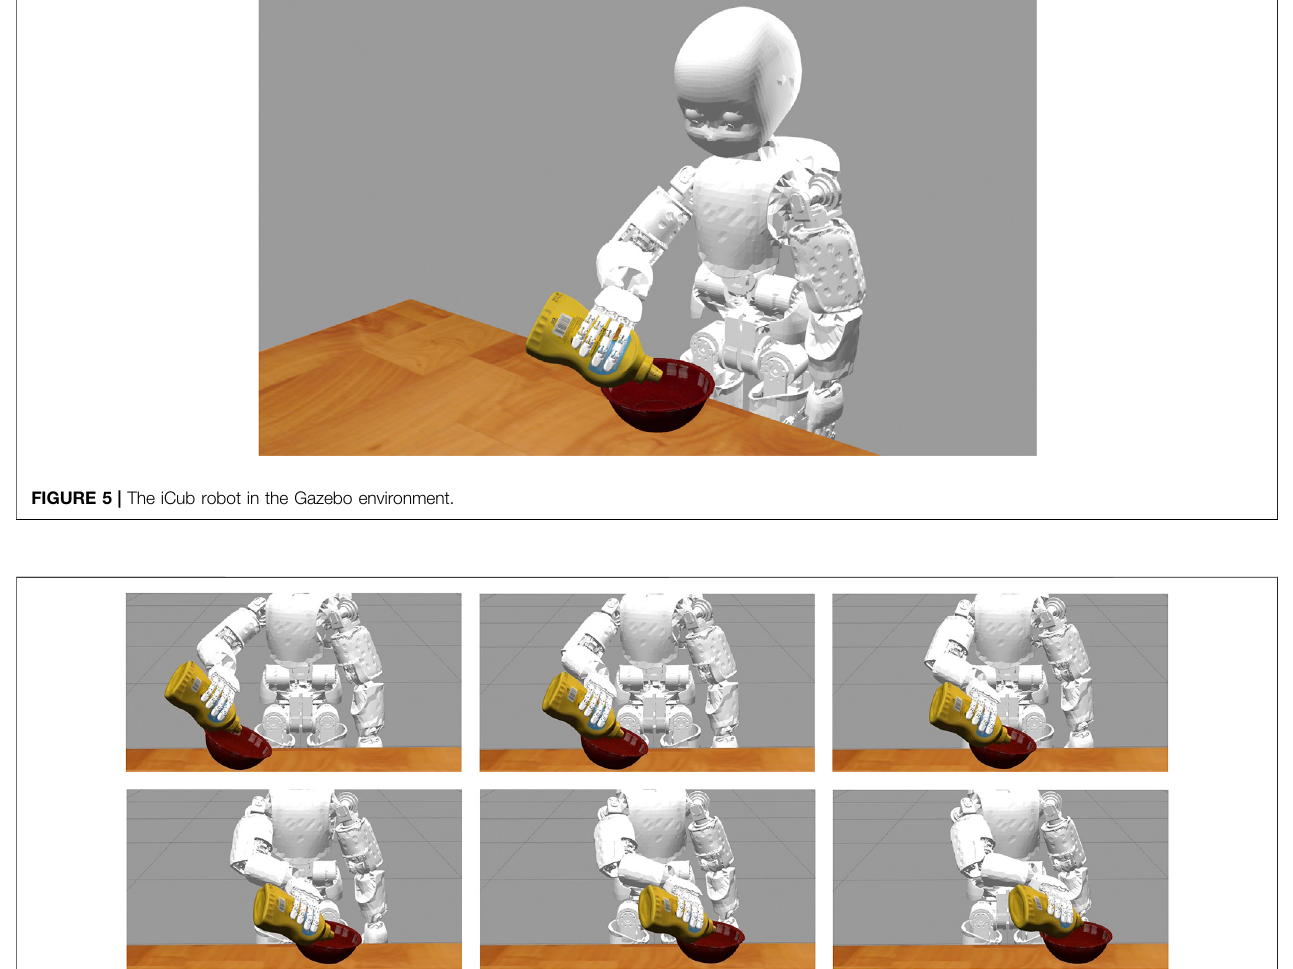
Frontiers in Robotics and AI |